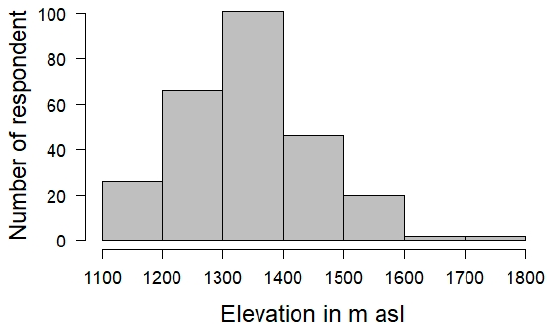
Figure 2. Distribution of respondents along elevation.